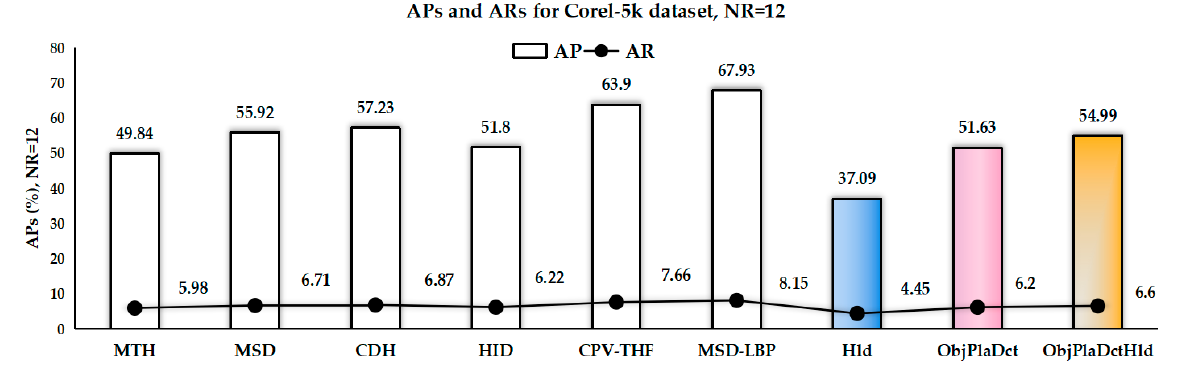
Figure 11. Comparison of different image retrieval methods on the Corel-5k dataset with Top NR = 12.